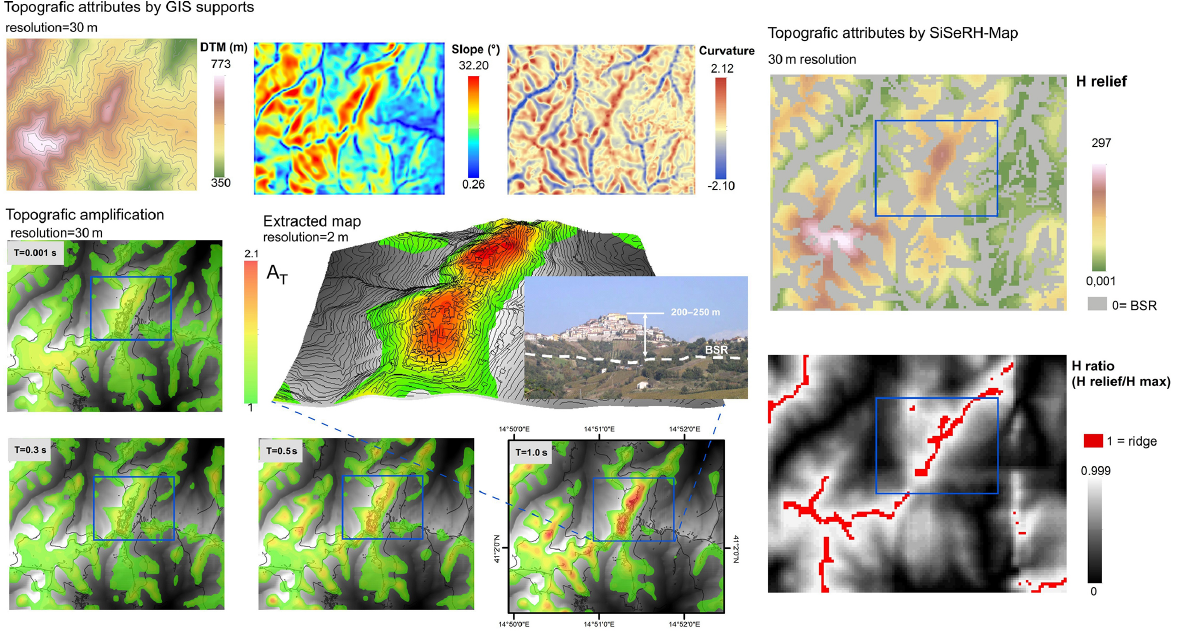
Figure 12. Example of topographic amplification computed on a real hill-mountain area of southern Italy: blue box is the automatic splitting map of the urbanized area of the village of